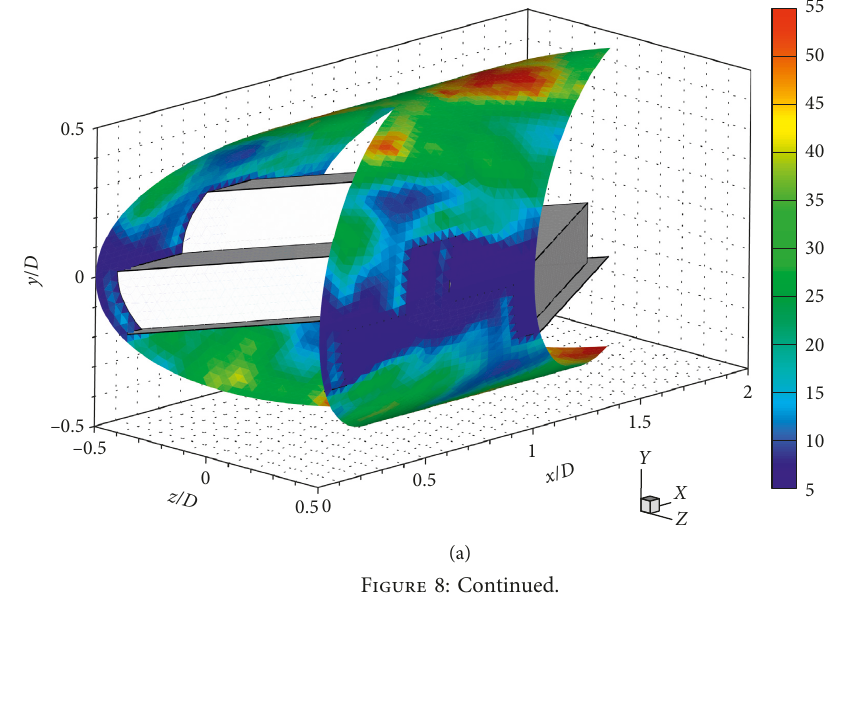
Figure 7: Temperature contour in transverse planes of the heat exchanger tube inserted with V-wavy surface at α (a) V-Downstream and (b)